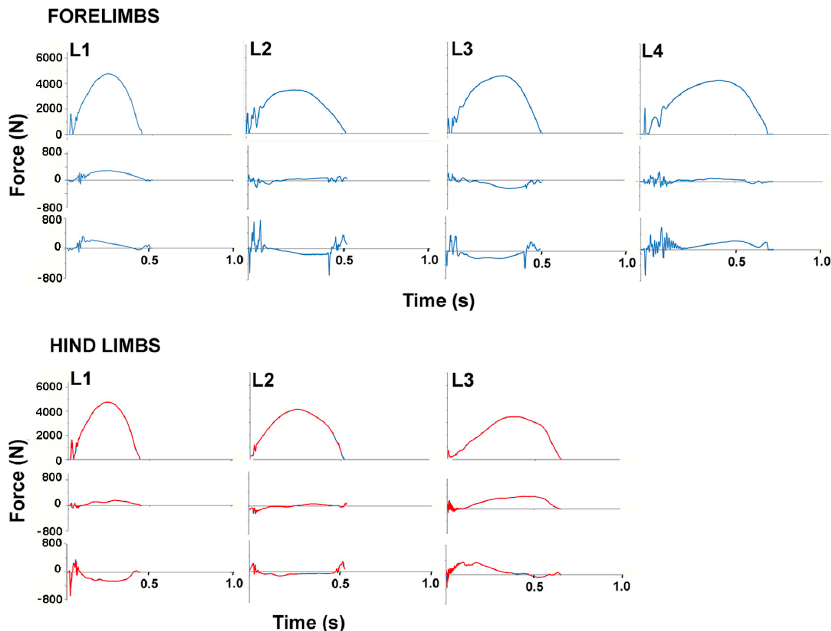
Figure 4. Ground reaction force traces for one typical stance phase of each Lusitano horse: left to right: L1, L2, L3, L4. Vertical (above), longitudinal (middle) and transverse (below) forces for forelimbs (upper panel) and hindlimbs (lower panel).